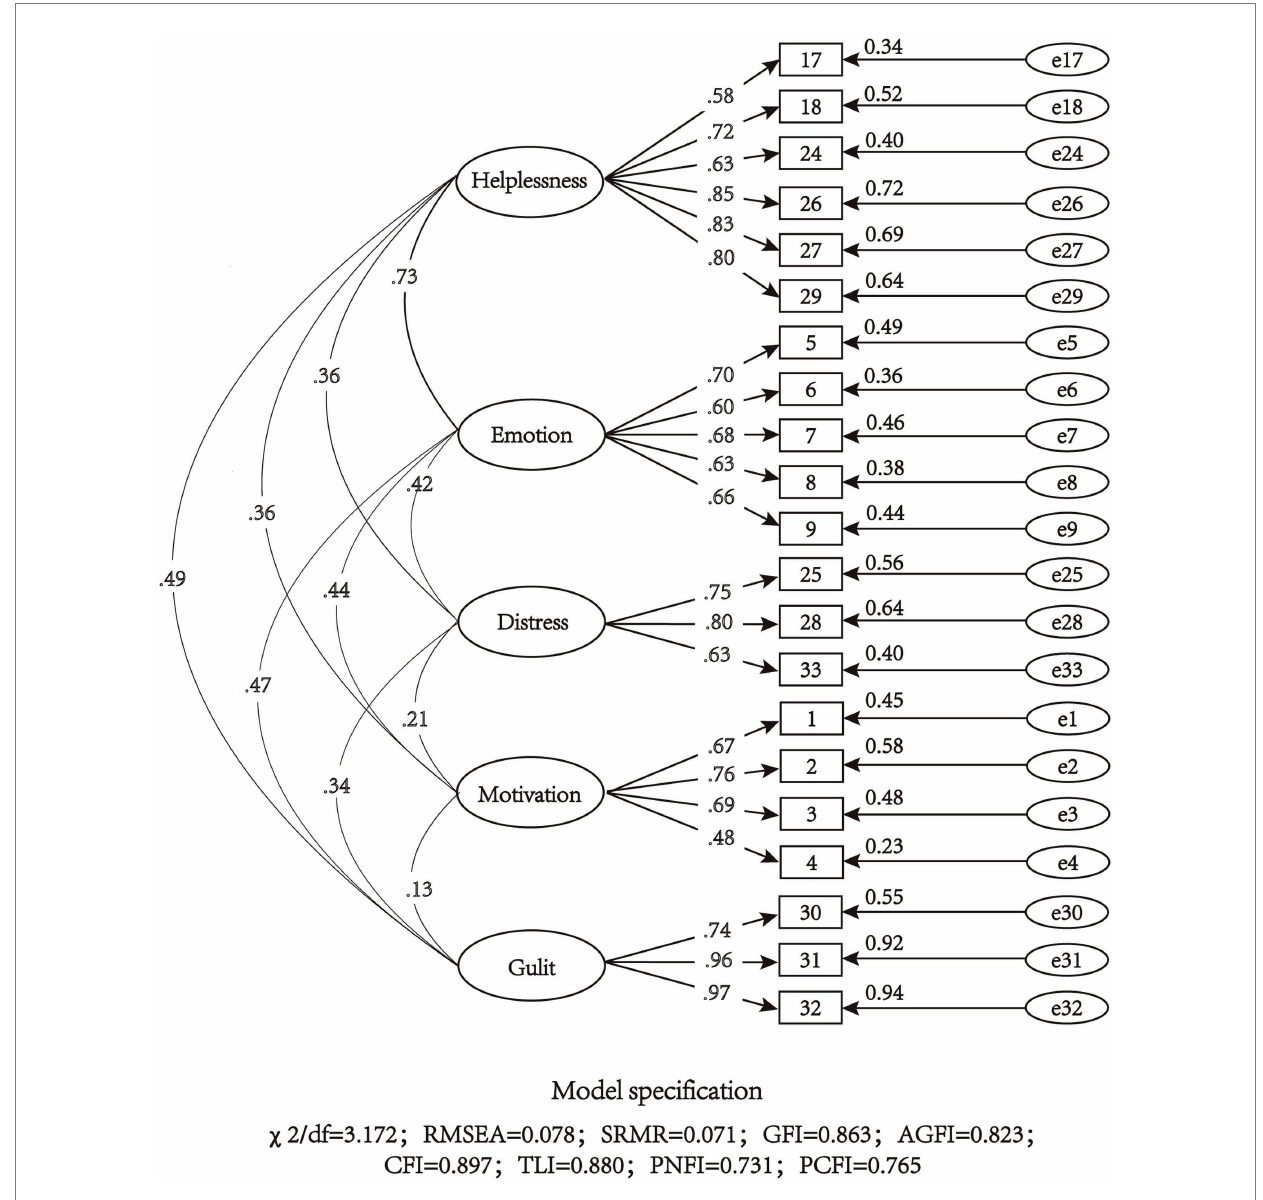
FIGURE 3 Model structure and standardized factor loadings of the five-factor model of the 21-item scale ( N = 360).